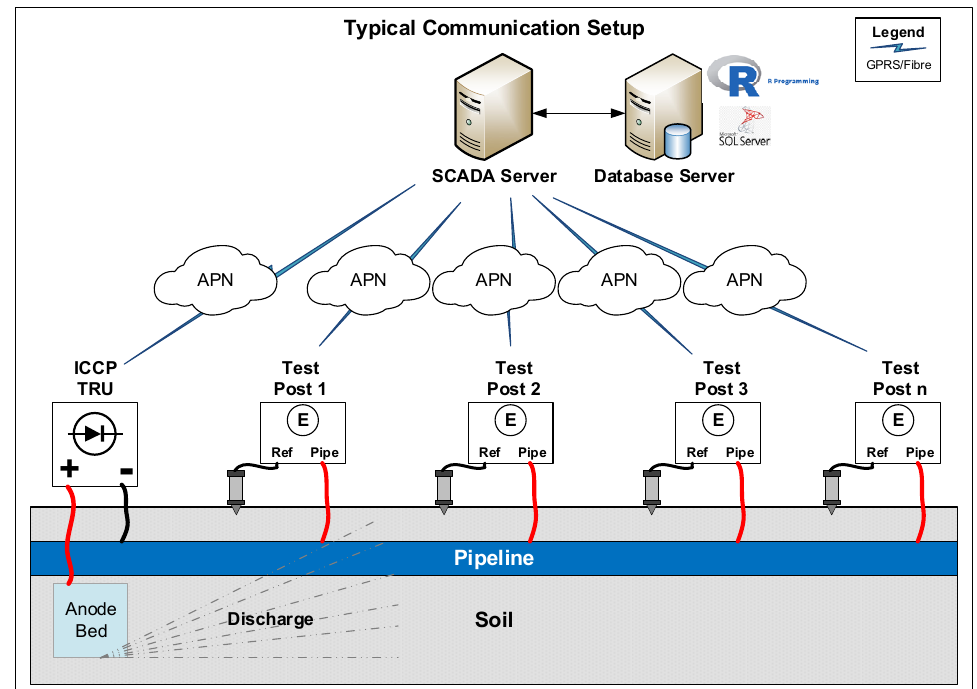
Figure 3. Typical CP remote monitoring architecture. Source: adapted from [42].